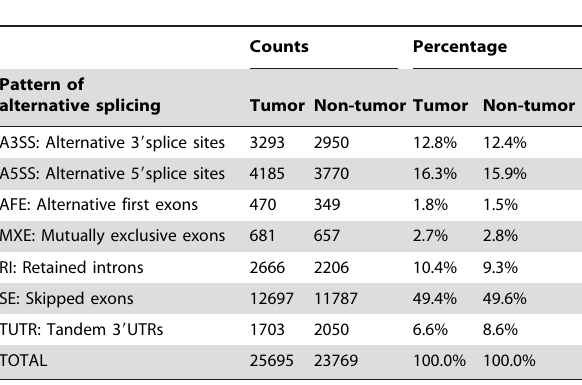
Table 4. Statistics of alternative splicing events in bladder